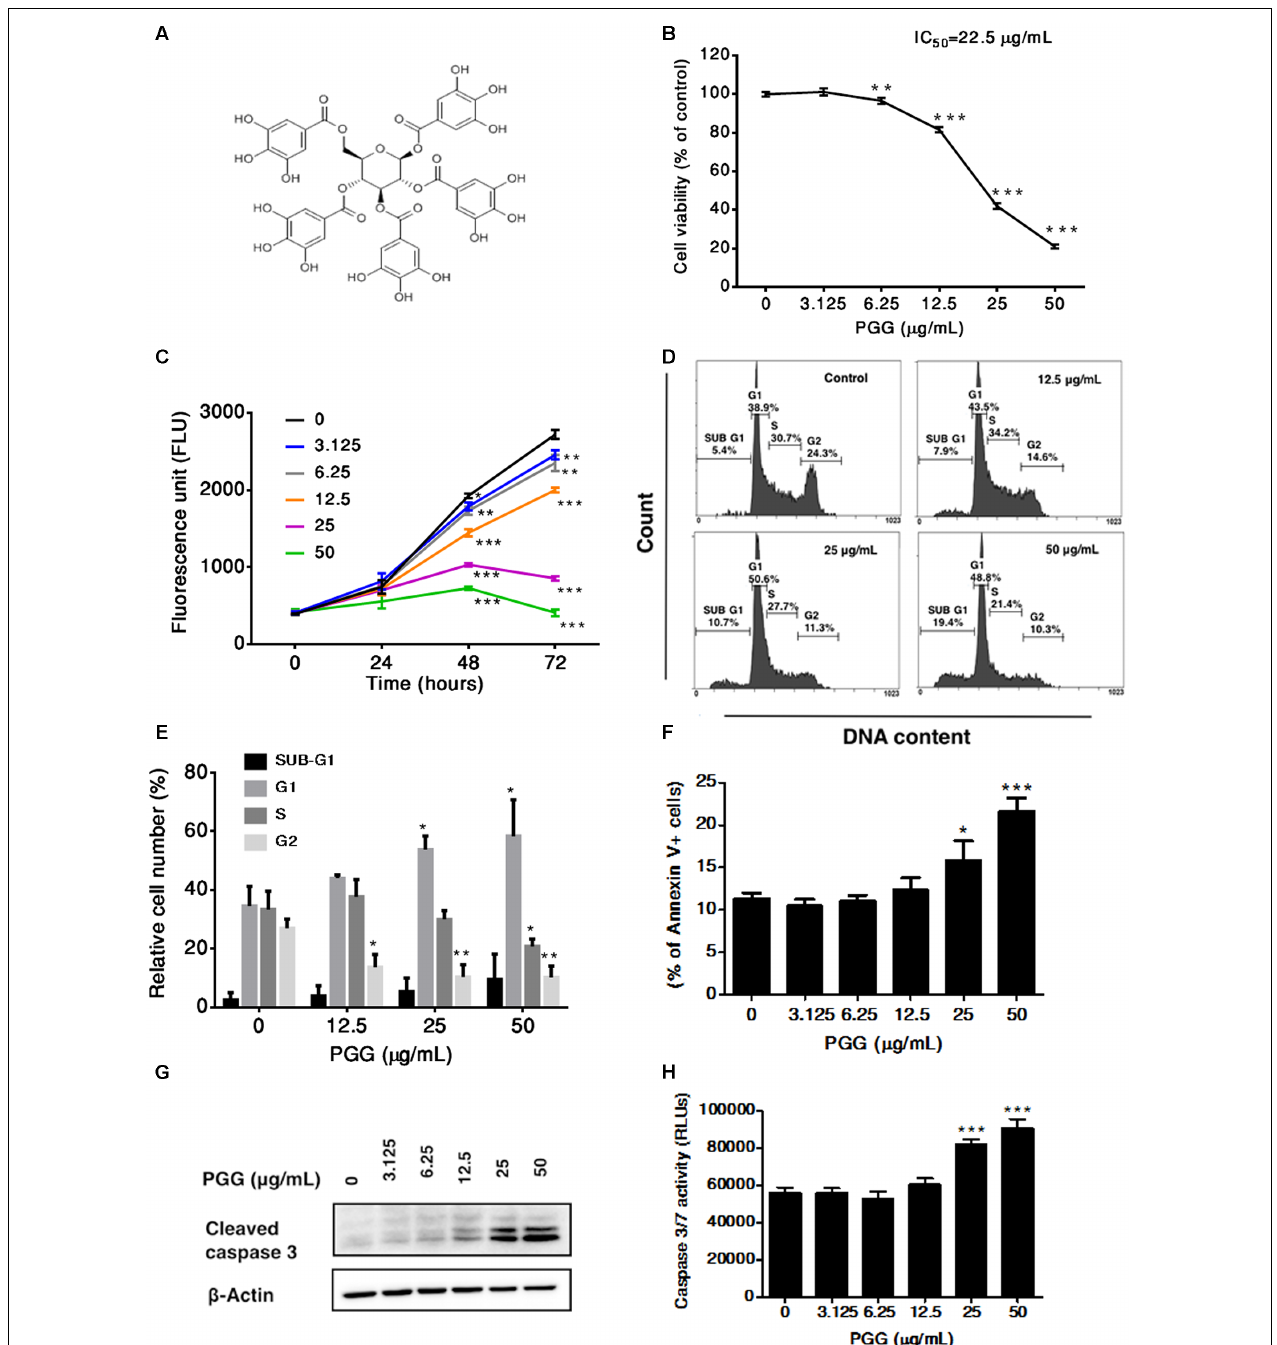
FIGURE 1 | Effect of PGG treatment on growth, cell cycle progression and induction of apoptosis in RPMI 8226 cells. (A) Chemical structure of 1,2,3,4,6-penta- O -galloyl-beta- D -glucopyranoside. (B) The viability of RPMI 8226 cells after 72 h of PGG treatment determined by the alamarBlue R (cid:13) assay as described in Section “Materials and Methods.” The percentage of viable cells normalized to solvent treated control were plotted. IC 50 value of PGG is shown in the figure. Results are as means ± SD ( n = 3). (C) RPMI 8226 cells were treated with indicated doses of PGG. Cell proliferation was evaluated at 0, 24, 48, and 72 h using alamarBlue R (cid:13) assay. Results are as means ± SD ( n = 3). (D) Representative images and (E) quantitative data indicates percentage of the cells at different phases of cell cycle in RPMI 8226 cells after 24 h of PGG treatment as assessed by DNA flow cytometric analysis. Data presented as means ± SD ( n = 3). (F) RPMI 8226 cells were cultured with indicated doses of PGG for 24 h, stained with Annexin V-FITC and analyzed by flow cytometry. The graph represents the percentages of annexin V+ apoptotic cells. Data presented as means ± SD ( n = 3). (G) RPMI 8226 cells were treated with indicated doses of PGG for 24 h and appearance of cleaved form of caspase-3 was determined by immunoblot analysis. Expression of β -actin was used as a loading control. (H) The activation of caspase 3/7 was observed in RPMI 8226 cells after 24 h of PGG treatment. Data presented as means ± SD ( n = 3). ∗∗∗ P < 0.001, ∗∗ P < 0.01, ∗ P < 0.05 (Student’s t -test).